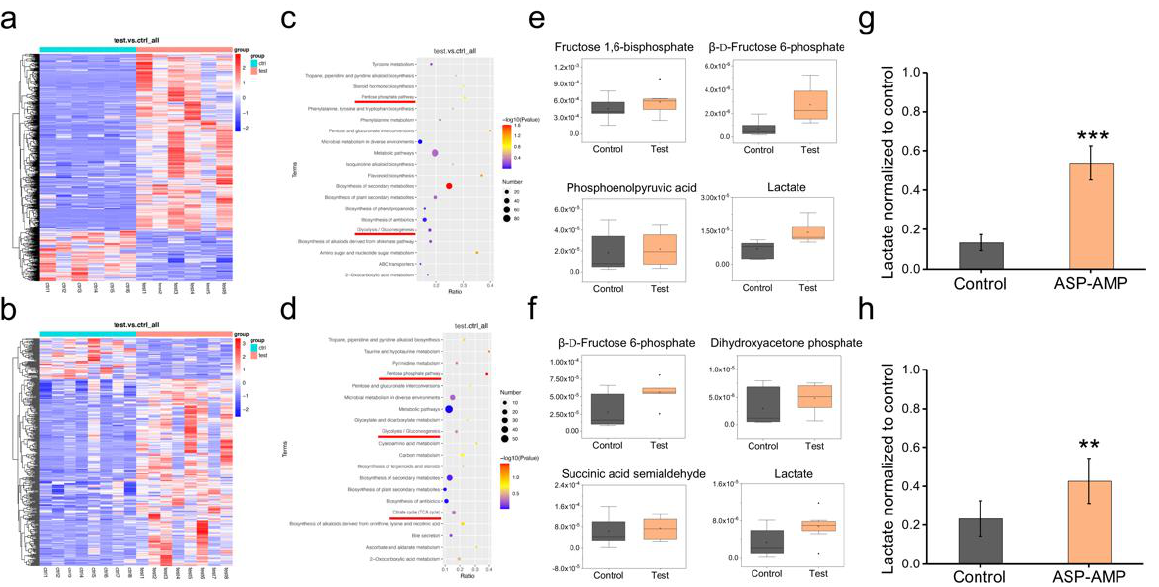
Figure 4. Differential metabolites found by metabolomics analysis and metabolic pathway analysis in NCTC clone 1469 cells ( n = 6) and liver tissue ( n = 8) after hepatectomy treated with ASP-AMP. Clustering heat map of total differential metabolites in hepatocytes ( a ) and liver tissue ( b ). Red refers to upregulated and blue refers to downregulated metabolites. KEGG pathway enrichment bubble diagram in hepatocytes ( c ) and liver tissue ( d ). The top 20 in terms of metabolite numbers are displayed, including glycolysis/gluconeogenesis, the citrate cycle (TCA cycle), and the pentose phosphate pathway. Six predictive metabolites related to glycometabolism are shown for hepatocytes ( e ) and liver tissue ( f ). Relative abundances were log10-transformed. Data were generated by LC-UHPLC. Lactate measurement in the hepatocyte supernatant ( g ) and mouse serum ( h ). Ctrl refers to the control group, and test refers to the experimental group treated with ASP-AMP for 3 days. ** p < 0.01, and *** p < 0.001.